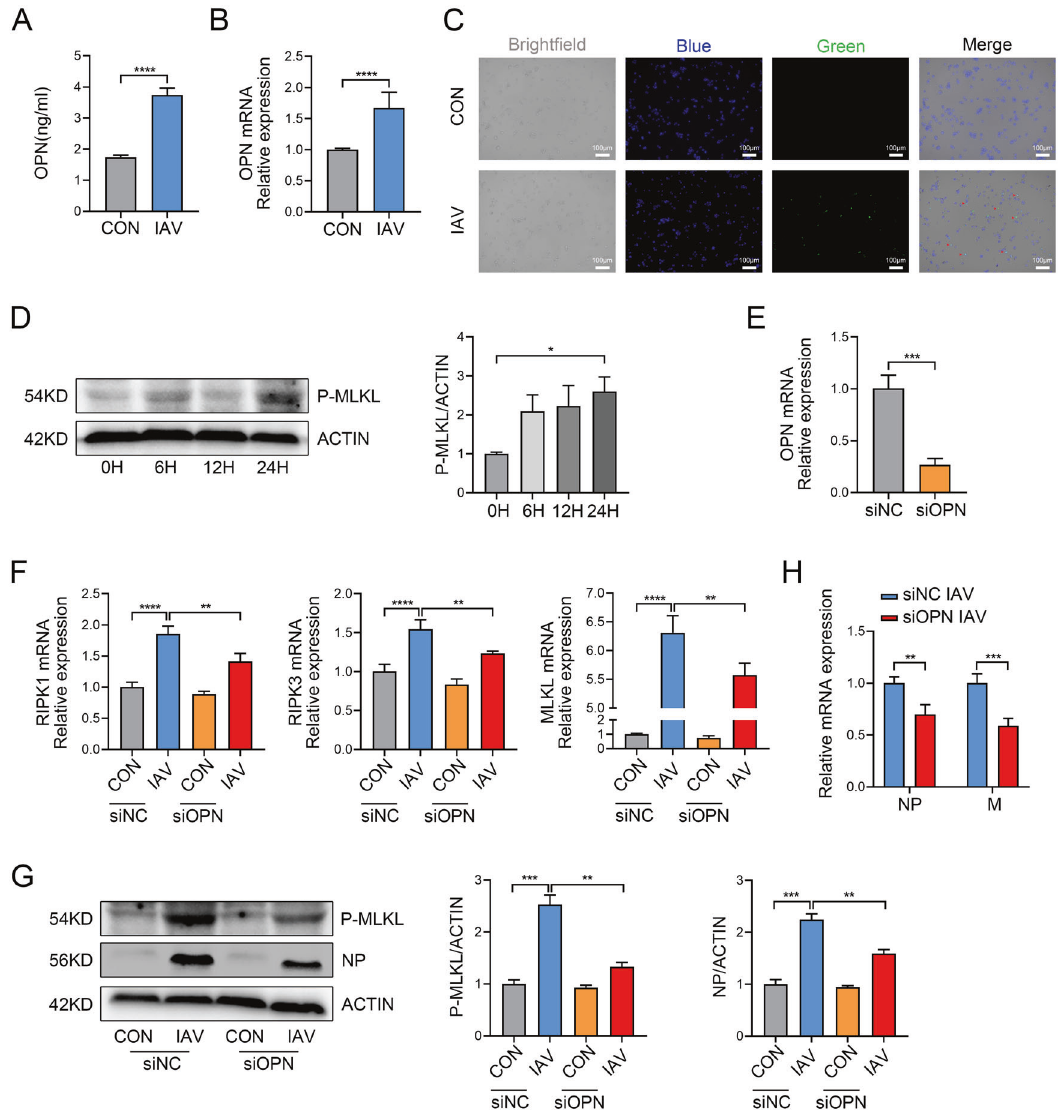
Fig. 4 OPN knockdown inhibits necroptosis in THP1 cells infected with IAV. PMA was added to the THP1 culture for 24 h to stimulate THP1 cells adherence and differentiation into macrophage-like cells. A , B THP1 cells were infected with 3 MOI PR8 for 24 h. A OPN protein levels in the cell culture supernatant. B OPN mRNA levels in the cell lysate. C THP1 cells were infected with GFP-PR8 (green) for 24 h and stained with DAPI (blue). Red arrows indicate positive cells. D THP1 cells were infected with 3 MOI PR8 for 0, 6, 12, and 24 h. Cell lysates were collected and subjected to western blot analysis. Each lane corresponds to an individual mouse. Lane-loading differences were normalized by levels of ACTIN. E – G OPN expression in THP1 cells was silenced using OPN-speci fi c small interfering RNA (siRNA) or nonspeci fi c siRNA (siNC). THP1 cells were infected with 3 MOI PR8 for 24 h. E OPN gene silencing ef fi ciency in THP1 cells. F RIPK1, RIPK3, and MLKL mRNA levels in THP1 cells. G Cell lysates were collected and subjected to western blot analysis. Each lane corresponds to an individual mouse. Lane-loading differences were normalized by levels of ACTIN. H Total viral titers in cell lysates were quanti fi ed by qPCR. Data was analyzed by Student ’ s t test (two-tailed) ( A , B , E , H ) or one-way ANOVA ( D , F , G ) and expressed as mean ± SEM. n = 3-7/group. ** p < 0.01; *** p < 0.001; **** p <